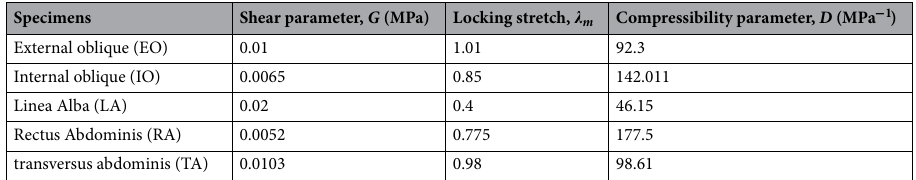
Table 1. Materials properties used for